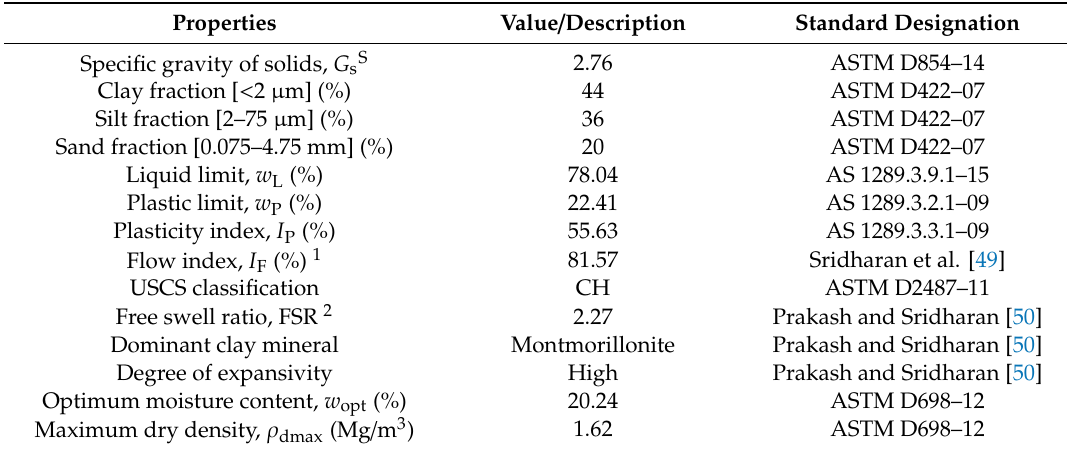
Table 1. Physical and mechanical properties of the clay